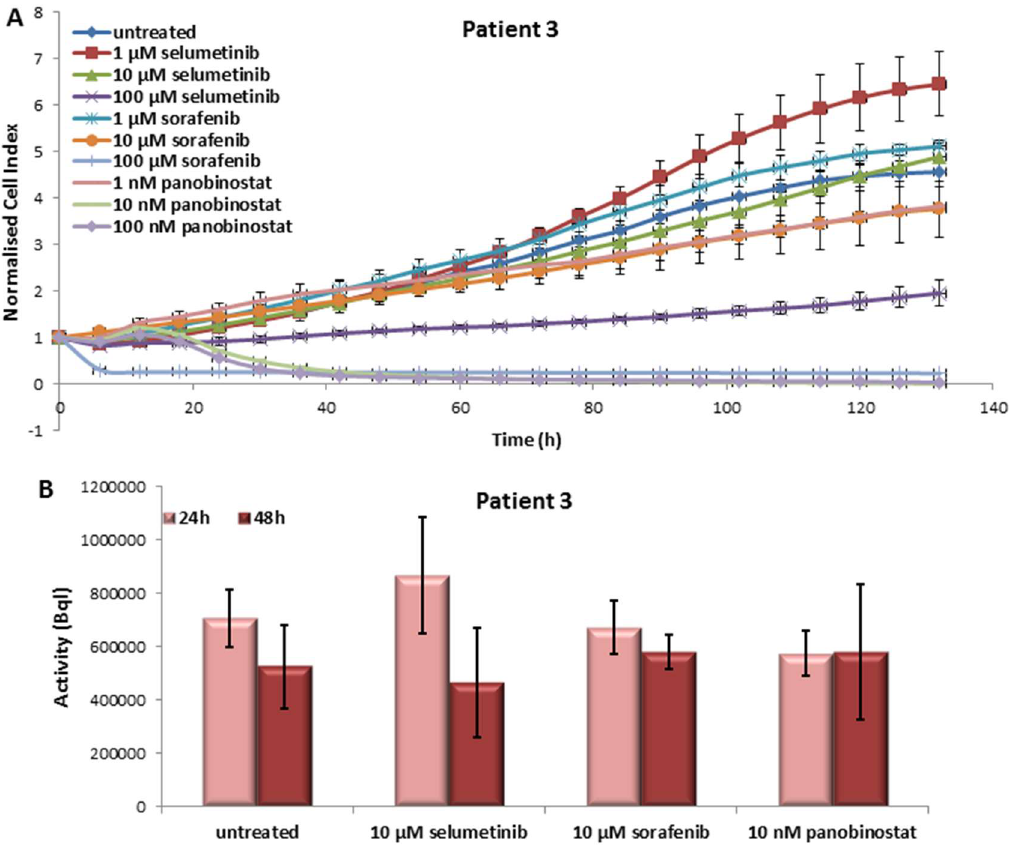
Figure 5. Effects of selumetinib, sorafenib and panobinostat on cell viability and RAI-U. Real time cell viability of PDTT cells (ATC—Patient 3) treated with 1 to 100 µM selumetinib and sorafenib and 1 to 100 nM panobinostat ( A ). RAI-U after 24 and 48 h of treatment with 10 µM selumetinib, 10 µM sorafenib and 10 nM panobinostat ( B ). Shown are means of experiments performed in triplicates ± SD ( A )/SEM ( B ).